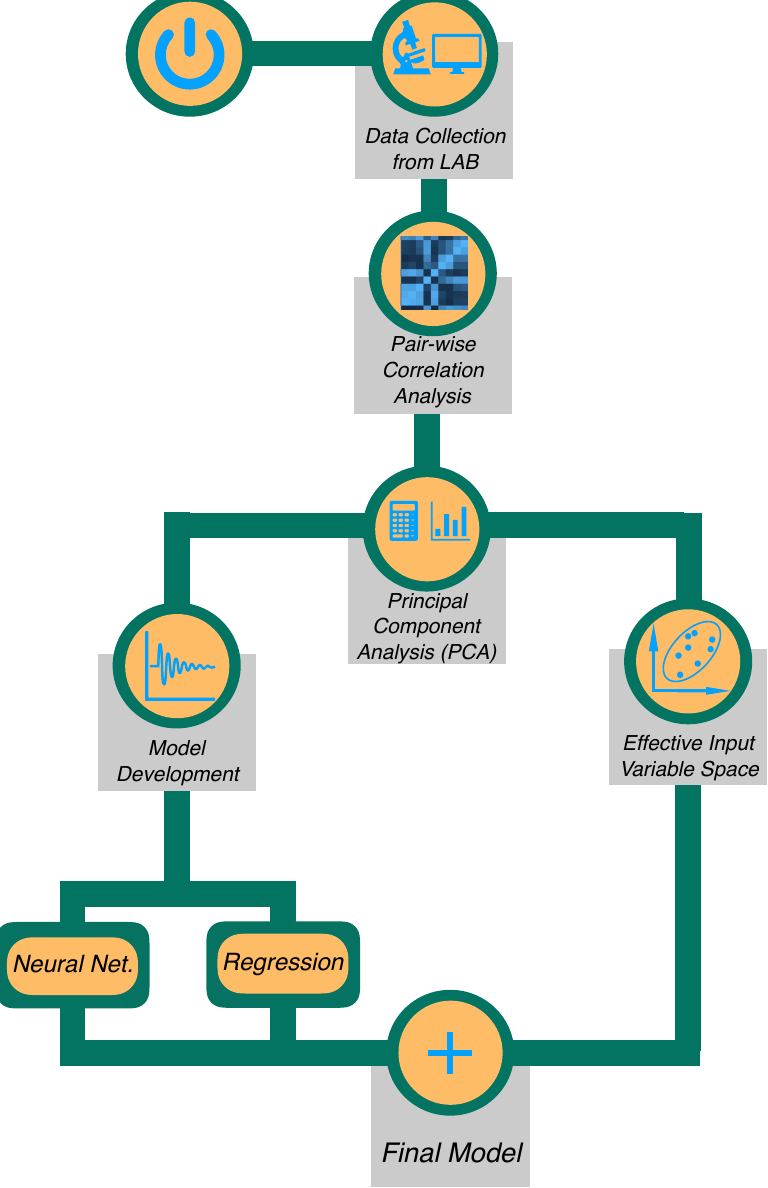
Figure 5. A summary of the methodologies used to develop the machine learning-based framework for predicting dynamic modulus (as an example of performance related property of asphalt